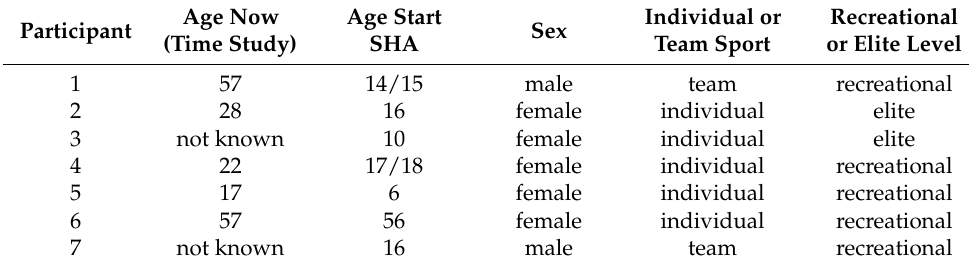
Table 1. Demographics of the